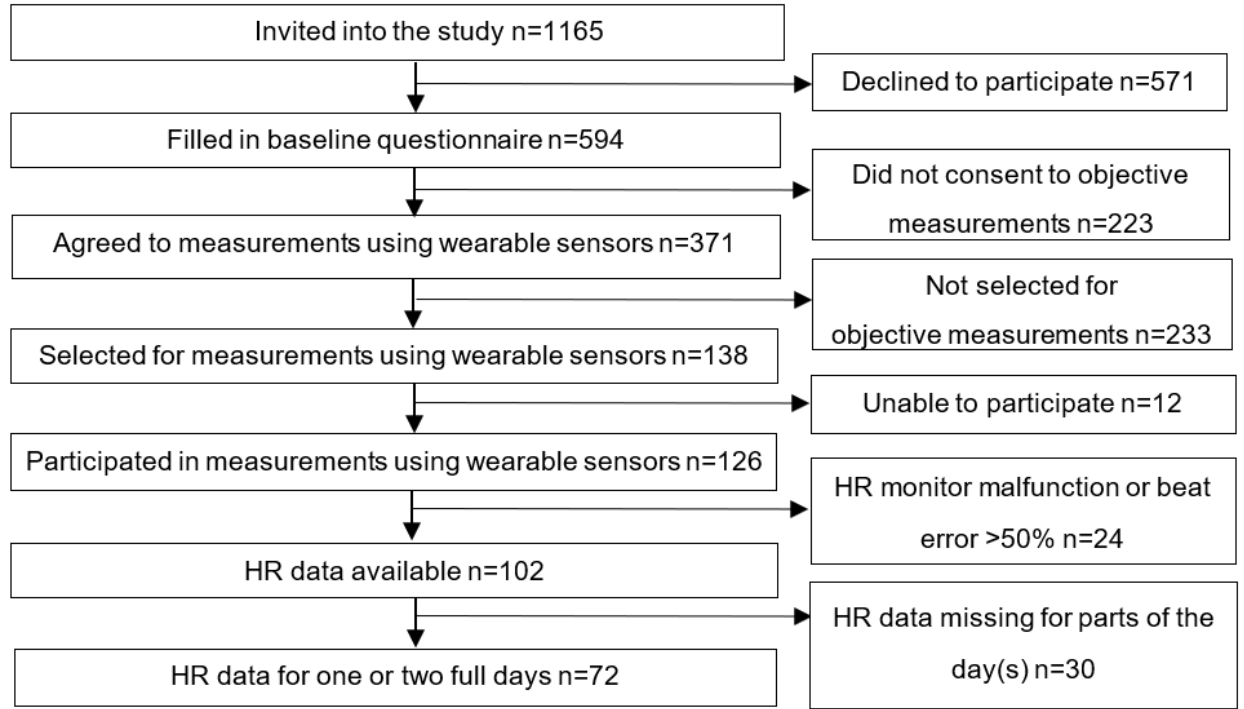
Figure 1. Flow diagram showing the selection procedure of participants for whom we had heart rate (HR) data for both work and leisure for at least one full 24 h day.